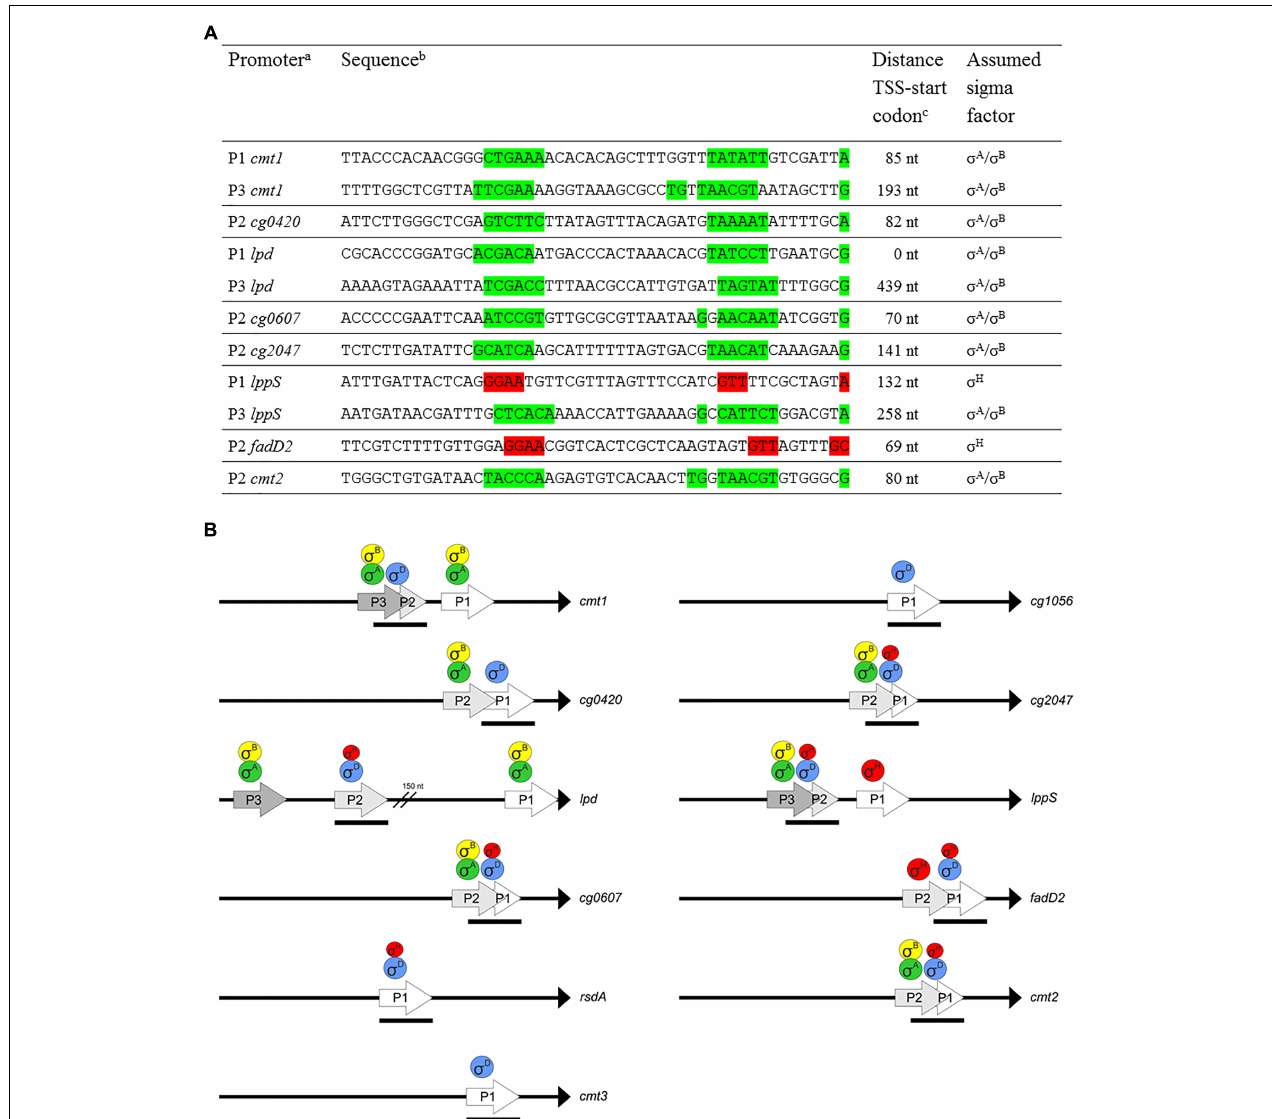
FIGURE 8 | Multiple promoters within upstream region of σ D -dependent genes. (A) Sequences of putative σ A / σ B - or σ H -dependent promoters within upstream region of σ D -dependent genes. The promoters identified closest to the translation start codon were designated P1. The suggested –35 and –10 (or extended –10) promoter elements and the respective TSS are highlighted in green ( σ A / σ B -dependent) or red ( σ H -dependent). TSS were detected by RNA-seq specific for transcription start sites. (B) Schematic representation of upstream regions of the genes with multiple promoters. To complete the studied promoter set, the fragments only carrying the σ D -dependent promoters P rsdA , P cmt3, and P cg1056 are also included. The proposed sigma factors regulating transcription from the individual promoters are shown above. Transcriptional starts are at the tips of the arrows. The length and positions of the bars below the arrows depict approximately the length and positions of the promoter-carrying DNA fragments (70 nt) used for both in vitro and in vivo assays. Translation initiation points are shown as black